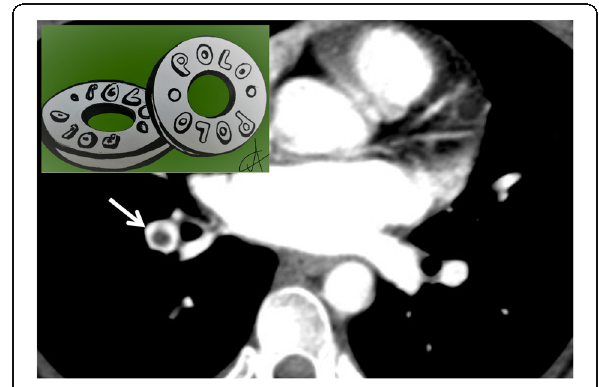
Fig. 25 Polo mint sign. A patient with acute pulmonary embolism: a blood clot (white arrow) surrounded by contrast media, reproduces inside the pulmonary vessel the “ polo mint sign ” appearance (similar to the famous polo mint in the embedded figure). Its recognition is very important for radiologists, because it represents a marker of acute embolism